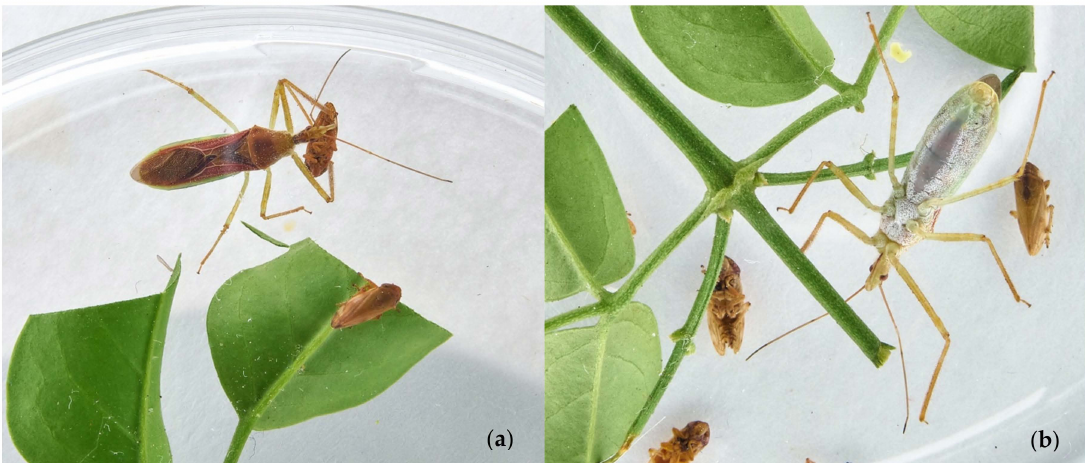
Figure 2. ( a , b ) LAB female reared in a Petri dish on jasmine twigs with meadow spittlebugs available prey.